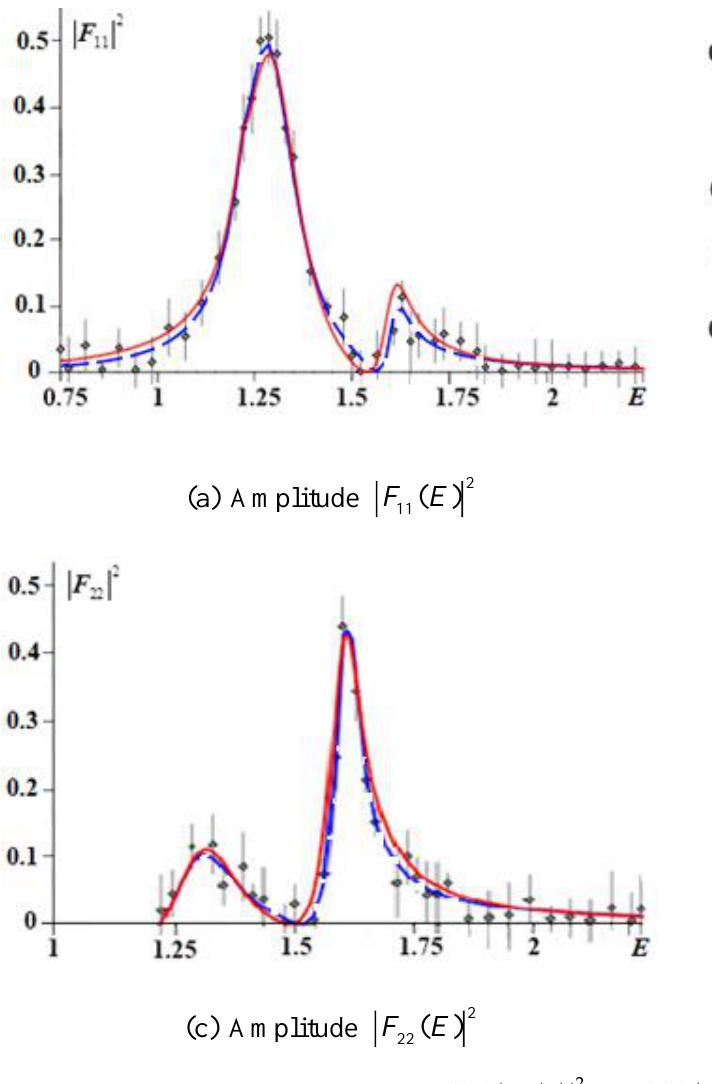
Figure 4. Panel ( a ) | F 11 ( E ) | 2 , panel ( b ) | F 12 ( E ) | 2 , panel ( c ) | F 22 ( E ) | 2 . Red solid lines—BW formula Figure 4. Panel (a) (44), blue dashed lines– K -matrix Equation (46); threshold E 2 = formula (44), blue dashed lines – К -matrix Equation (46); threshold